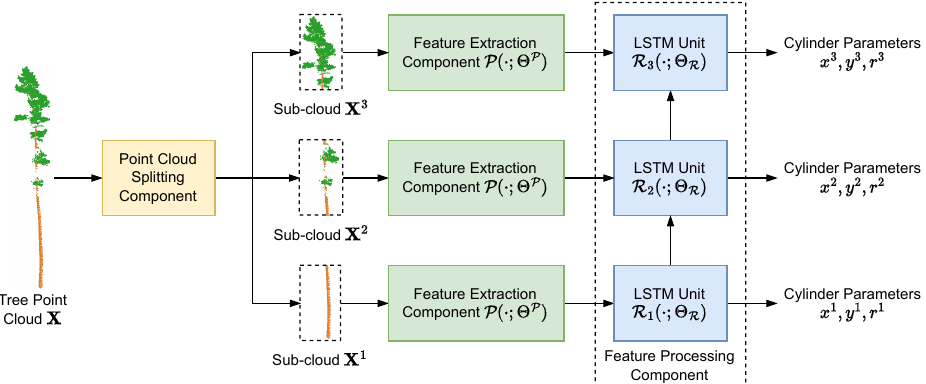
Figure 5. In our tree parameter estimation model, we use only three height segments as an example for simplicity. First, we split the input point cloud X into the different sub-clouds X 1 , X 2 , and X 3 by height segments. Then we pass each point cloud segment through the point cloud feature extraction component P ( · ; Θ P ) to produce the features for each height segment. Finally, we employ an LSTM [74] model to process the features of all three sub-clouds and output the cylinder parameters for each height